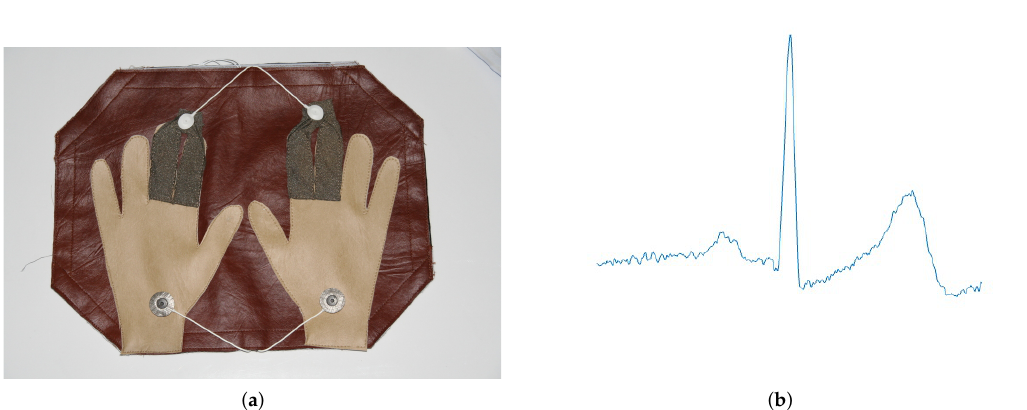
Figure 2. Example of the device and the ECG from the CYBHi dataset. ( a ) Example of the device used to get the ECG signal. Source: [20]. ( b ) Example of the ECG shape extracted from the CYBHi